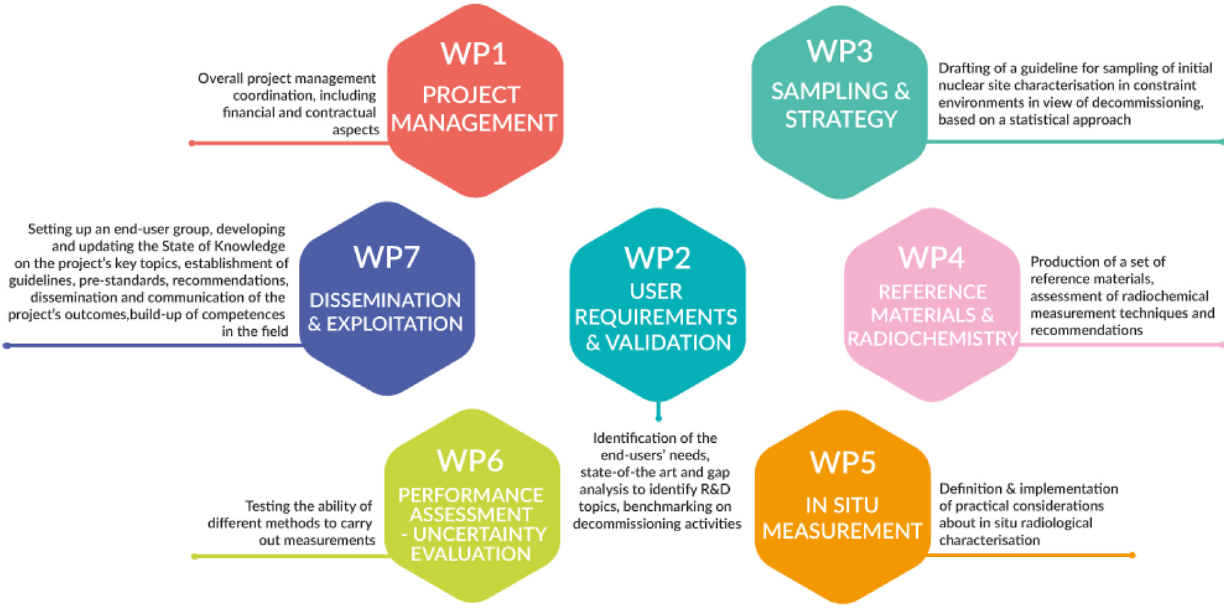
Fig. 1. INSIDER work package